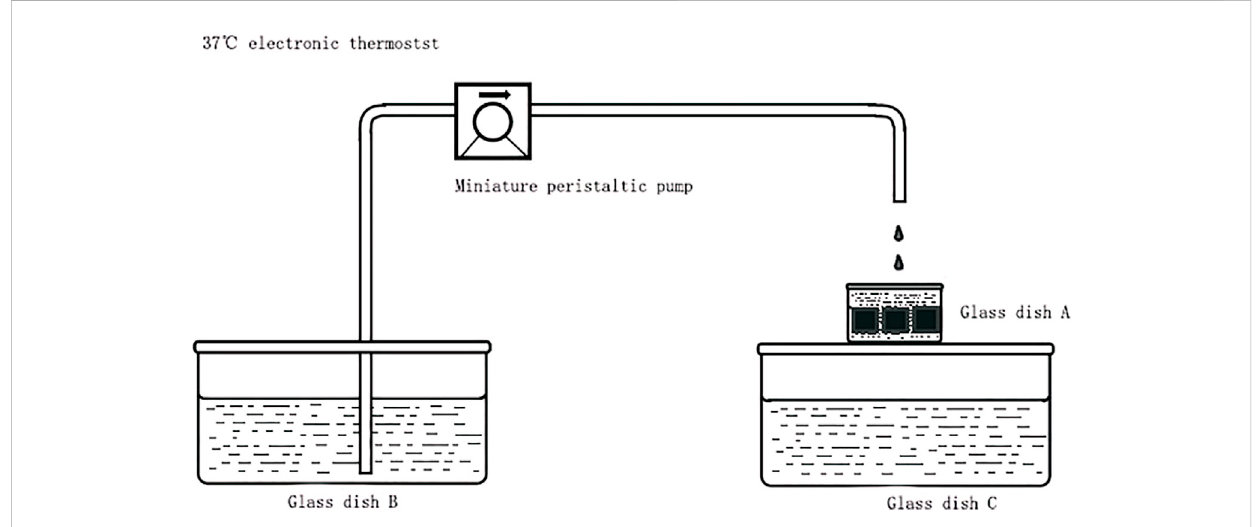
FIGURE 2 Schematic diagram showing the in vitro simulated oral environment